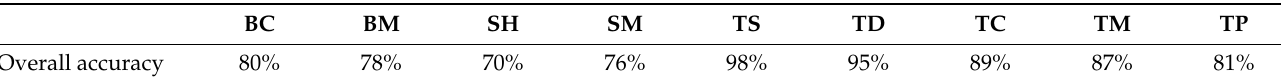
Table 5. Overall accuracy values of the random forest classifier for zones in the EASM region based on 75% of the reference data.